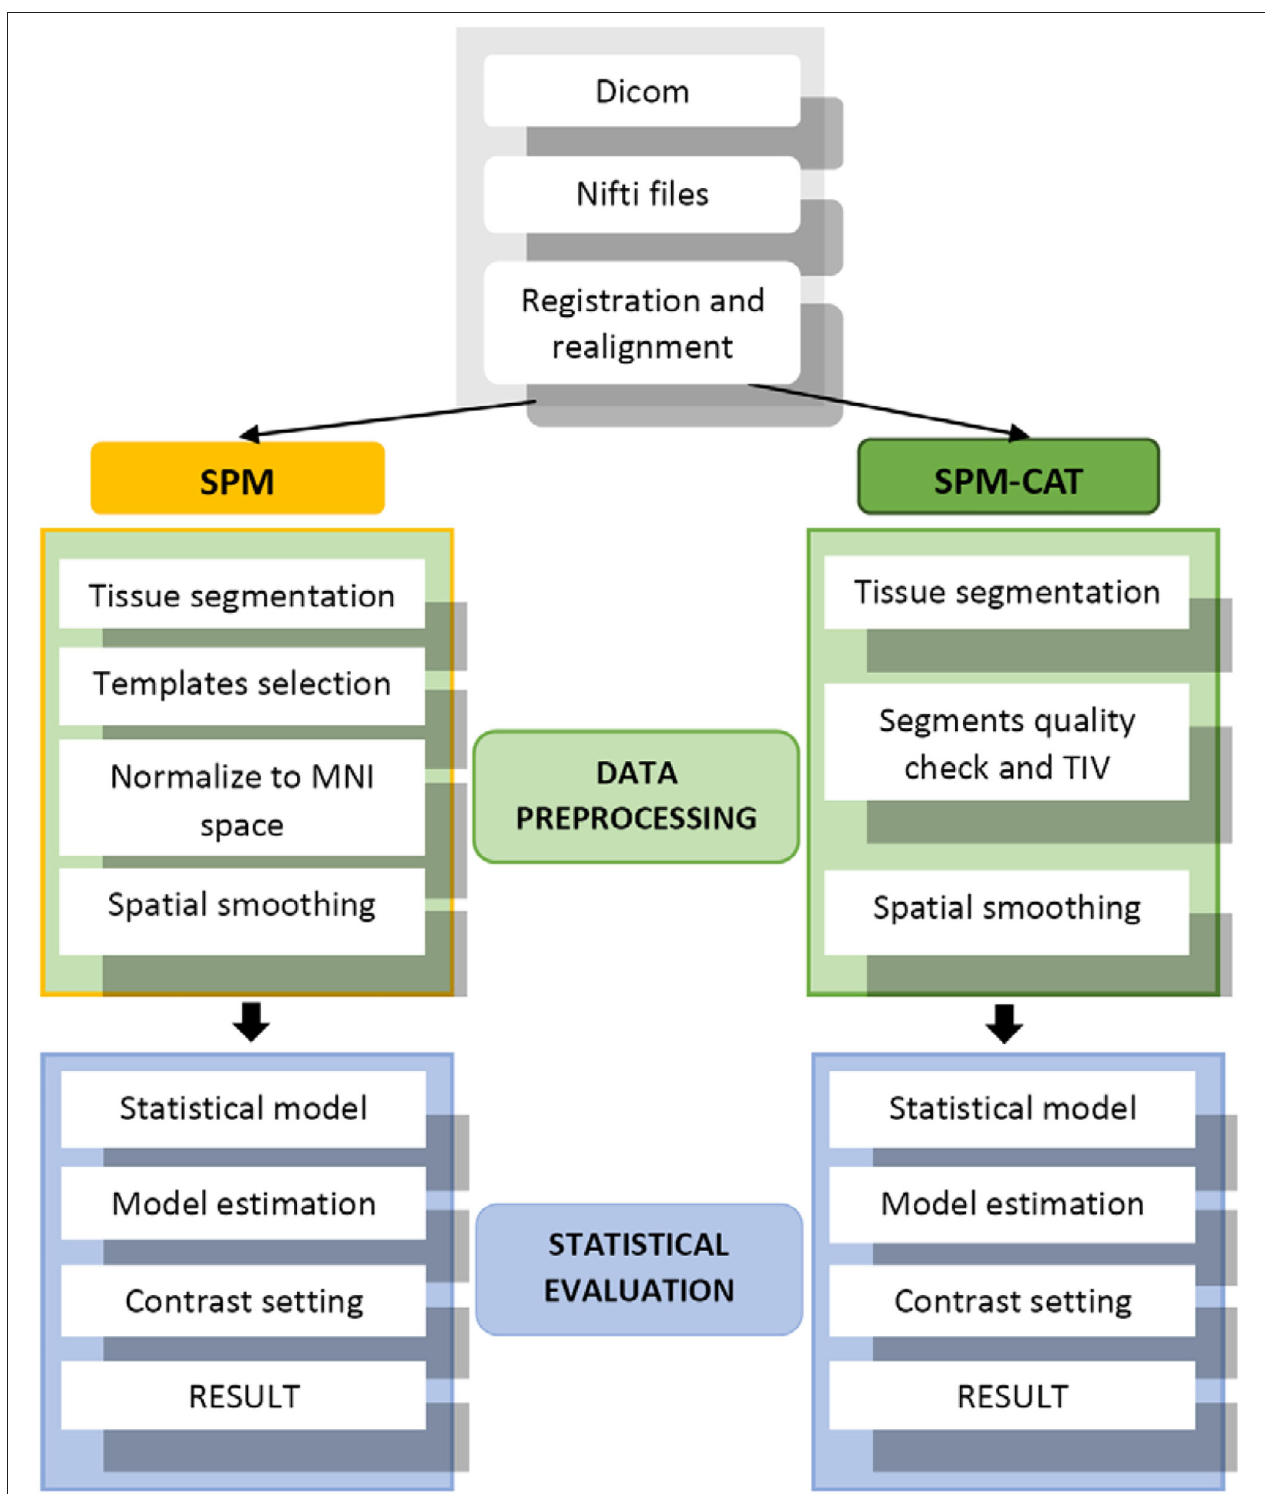
FIGURE 2 | SPM and SPM-CAT